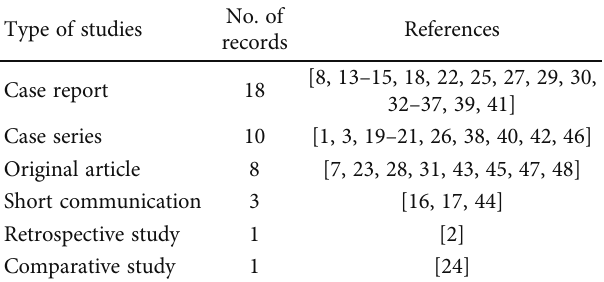
Table 2: Type of studies